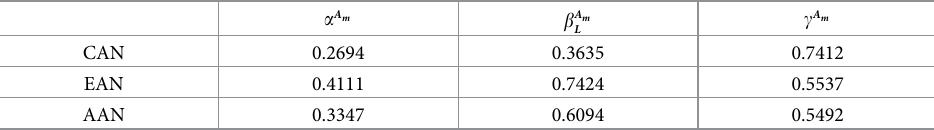
Table 1. CRA composite indices by airport network under COVID-19.